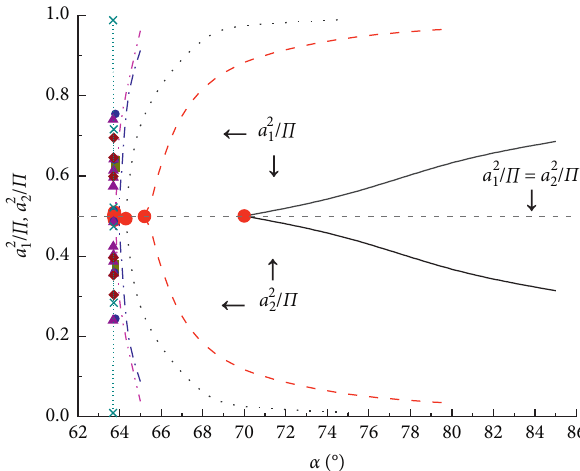
Figure 1: Wave energy distribution ( a 2 class-I Bragg resonant wave system in the case of k � 0.05, and δω � 0. Solid line: a bk 1 a k � 0.02; dotted line: a 1 1 dash-double-dotted line: a k � 0.07; triangle: a a 1 1 a k � 1 1 Table 1: Bifurcation points of incident angle α versus incident wave k steepness a of the class-I Bragg exact resonant wave system in 1 1 d � 2.5, bk the case of k 1